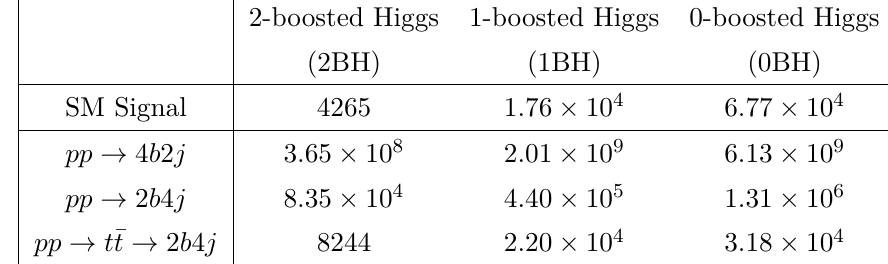
Table 6 . The numbers of events for 2BH, 1BH and 0BH cases at 100 TeV collider are